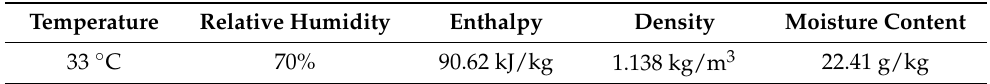
Table 1. Outdoor parameters required for the calculation of the air-supply volume of air-conditioning units.